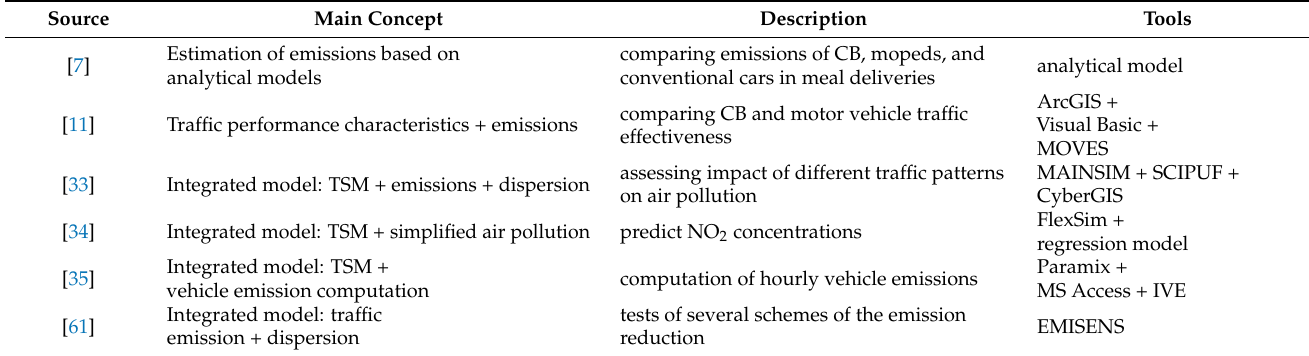
Table 3. Approaches to the estimation of the environmental impact of transport and corresponding tools.